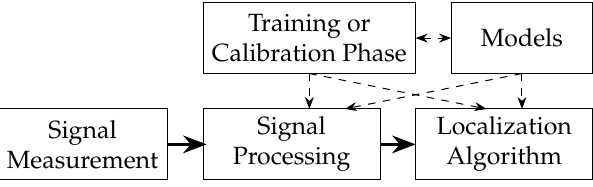
Figure 2. General function blocks of a DFL